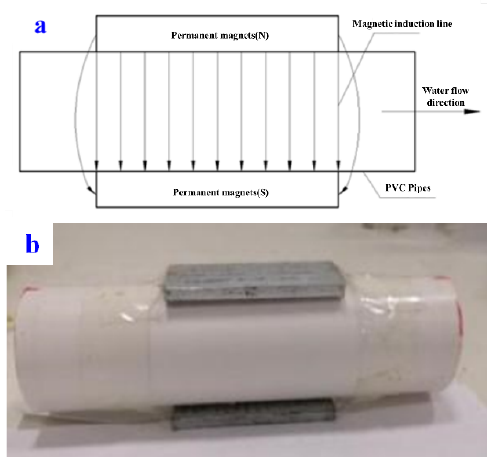
Fig. 3. Diagram of the treatment device by magnetic field (a: diagram; b: picture).